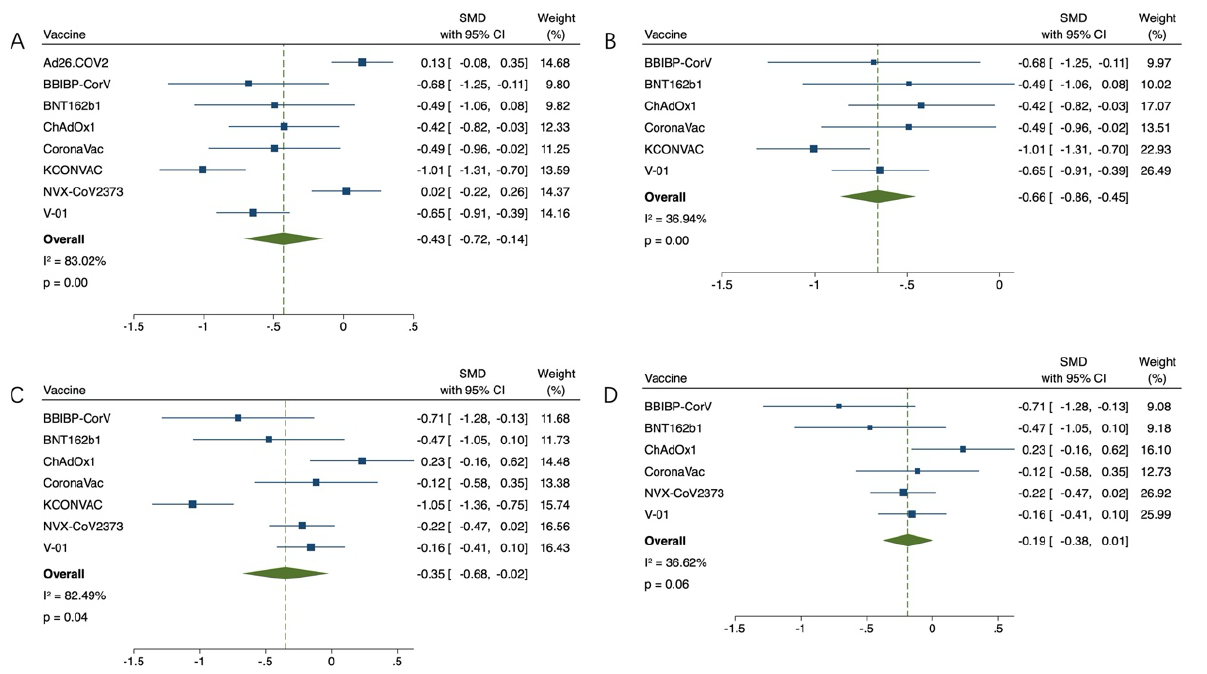
Figure 2. ( A , B ) Meta-analysis of GMTS between the experimental group (older adults) and the control group (younger adults) after the first vaccination, and results after reducing heterogeneity. ( C , D ) Meta-analysis of the GMTS of the experimental group (older adults) and the control group (young adults) after the last vaccination, and results after reducing heterogeneity. Blue squares represent effect sizes for a single study, and green rhombus represent pooled results for all studies.